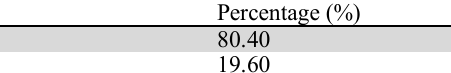
Specific tools apart from